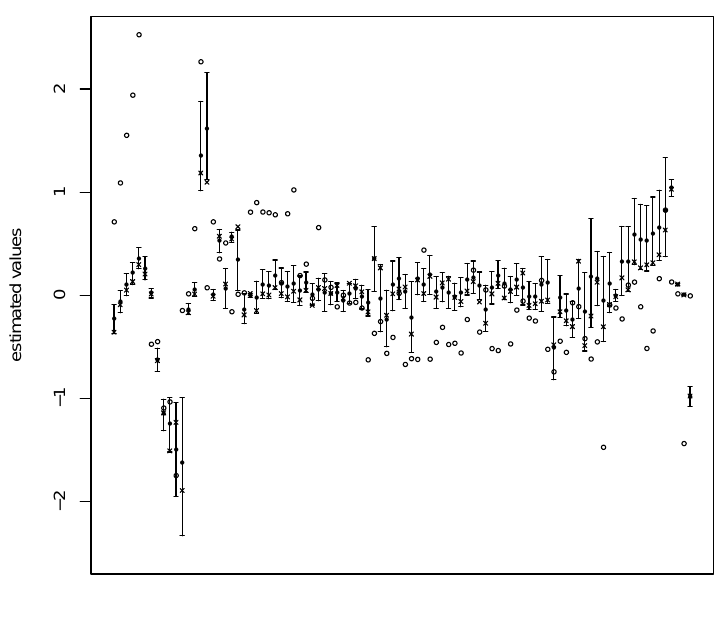
Figure 5. Means and 95% confidence intervals for all parameters of the